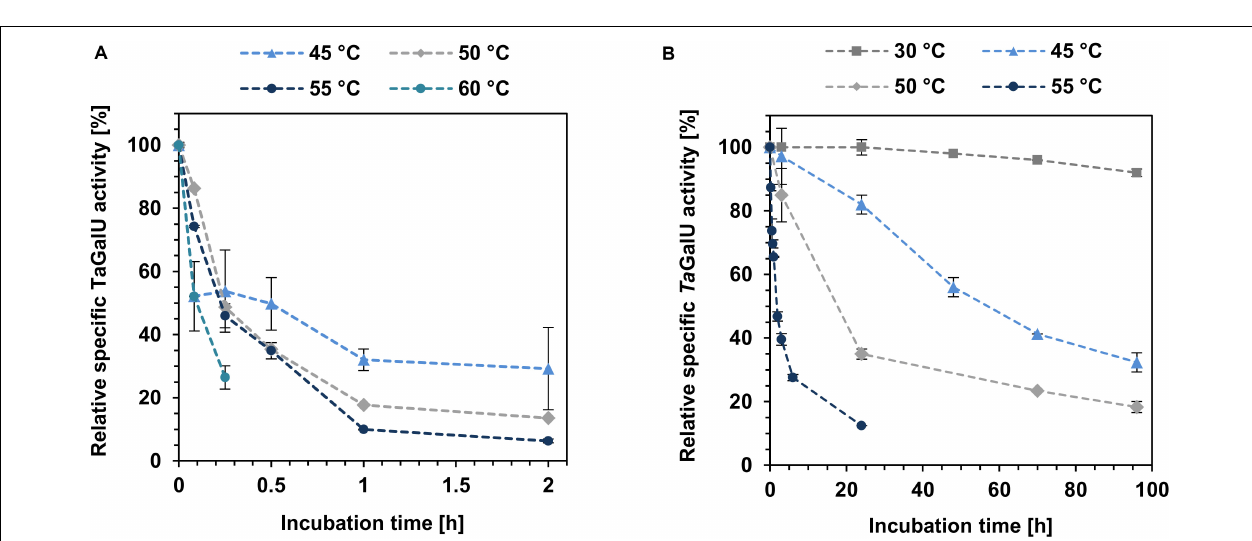
FIGURE 7 | Temperature stability of free (A) and immobilized Ta GalU (B) . (A) The reaction solution contained the following ingredients: 2 mM UTP, 30 mM G1P, 3 mM MgCl 2 , 50 mM Hepes, pH7.0, 0.08 µ g mL − 1 Ta GalU in 1 mL reaction volume. Incubation and performance of the reaction was carried out at indicated temperatures. 100% relative activity corresponds to the specific activity before incubation. Means of triplicates with standard deviations are shown. (B) Reaction solution contained 2 mM UTP, 2 mM G1P, 3 mM MgCl 2 , 50 mM Hepes buffer, pH 7.0, 0.2591 µ g mL − 1 Ta GalU immobilized on amino modified MCF. Reaction was carried out at indicated temperatures in 3 mL reaction volume. 100% relative activity corresponds to the specific activity before incubation. Means of triplicates with standard deviations are